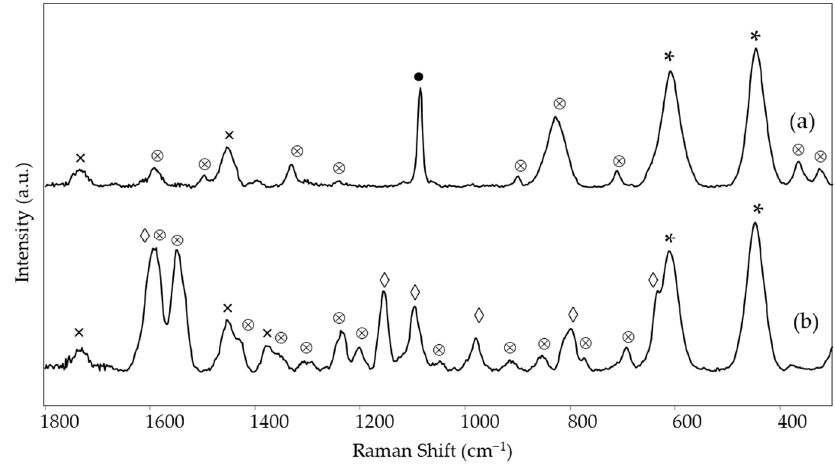
Figure 3. SSE™ Raman spectra of yellow areas: ( a ) The North pole and the tree of life , area 5 and ( b ) Earthquake , area 2. Legend:  = pigment (for wavenumbers and assignments see Table 2), * = rutile,  = CaCO 3 ,  = resin,  = binder (see text).